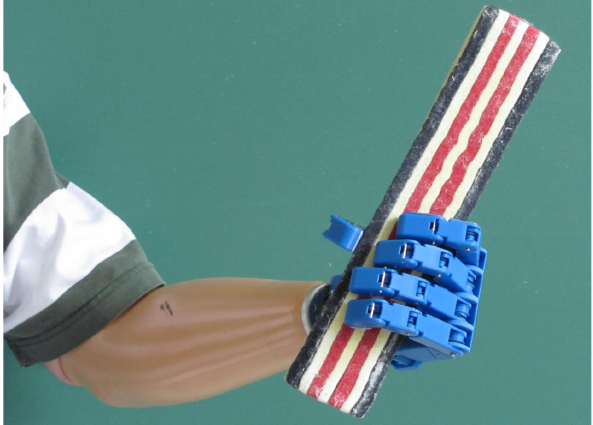
Figure 13. The prosthetic hand grasping a nut with an opposing pinch grasp.